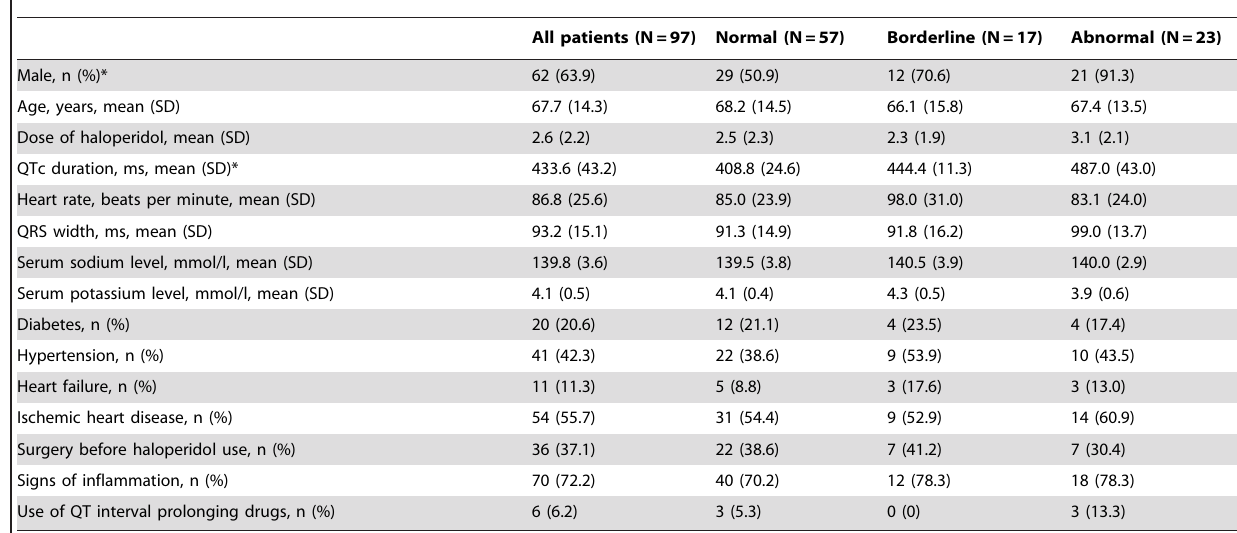
Table 1. Baseline characteristics of patients: all, and stratified in subgroups based on QTc duration before haloperidol.